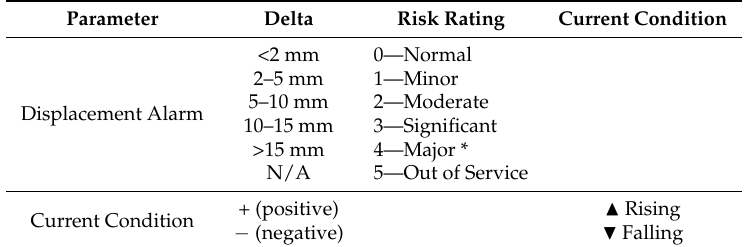
Table 4. Structure and characteristics of risk ratings and current condition parameters.